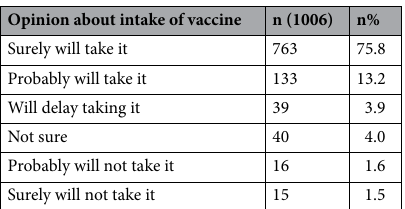
Table 2. Frequency distribution of participants’ opinion concerning their vaccine intake.